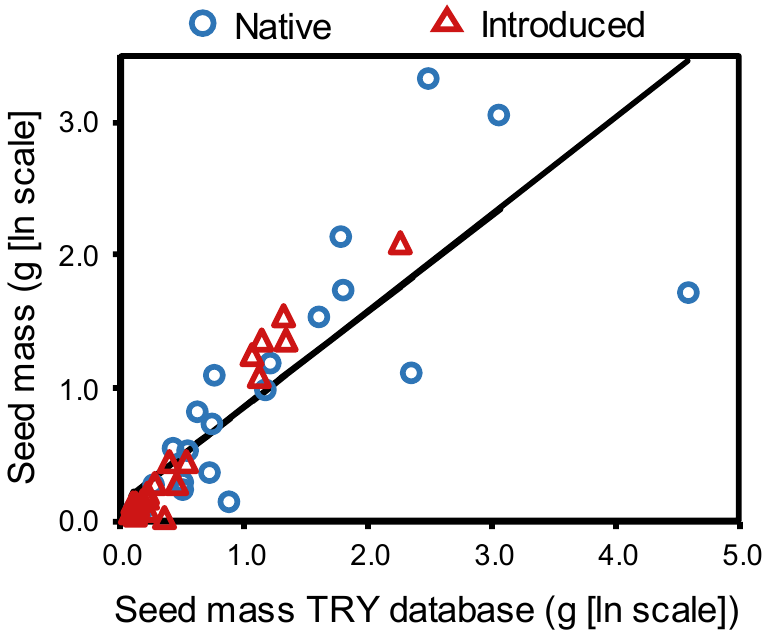
Figure 3. Seed mass (ln [mg + 1]) as compared between local measurements and values obtained from the TRY trait database for 23 native and 25 introduced grassland species in Montana, USA. Despite large variation between data sources for some species, seed mass measures were signifi- cantly correlated (see text); solid line represents the predicted relationship, and open symbols show observed values.